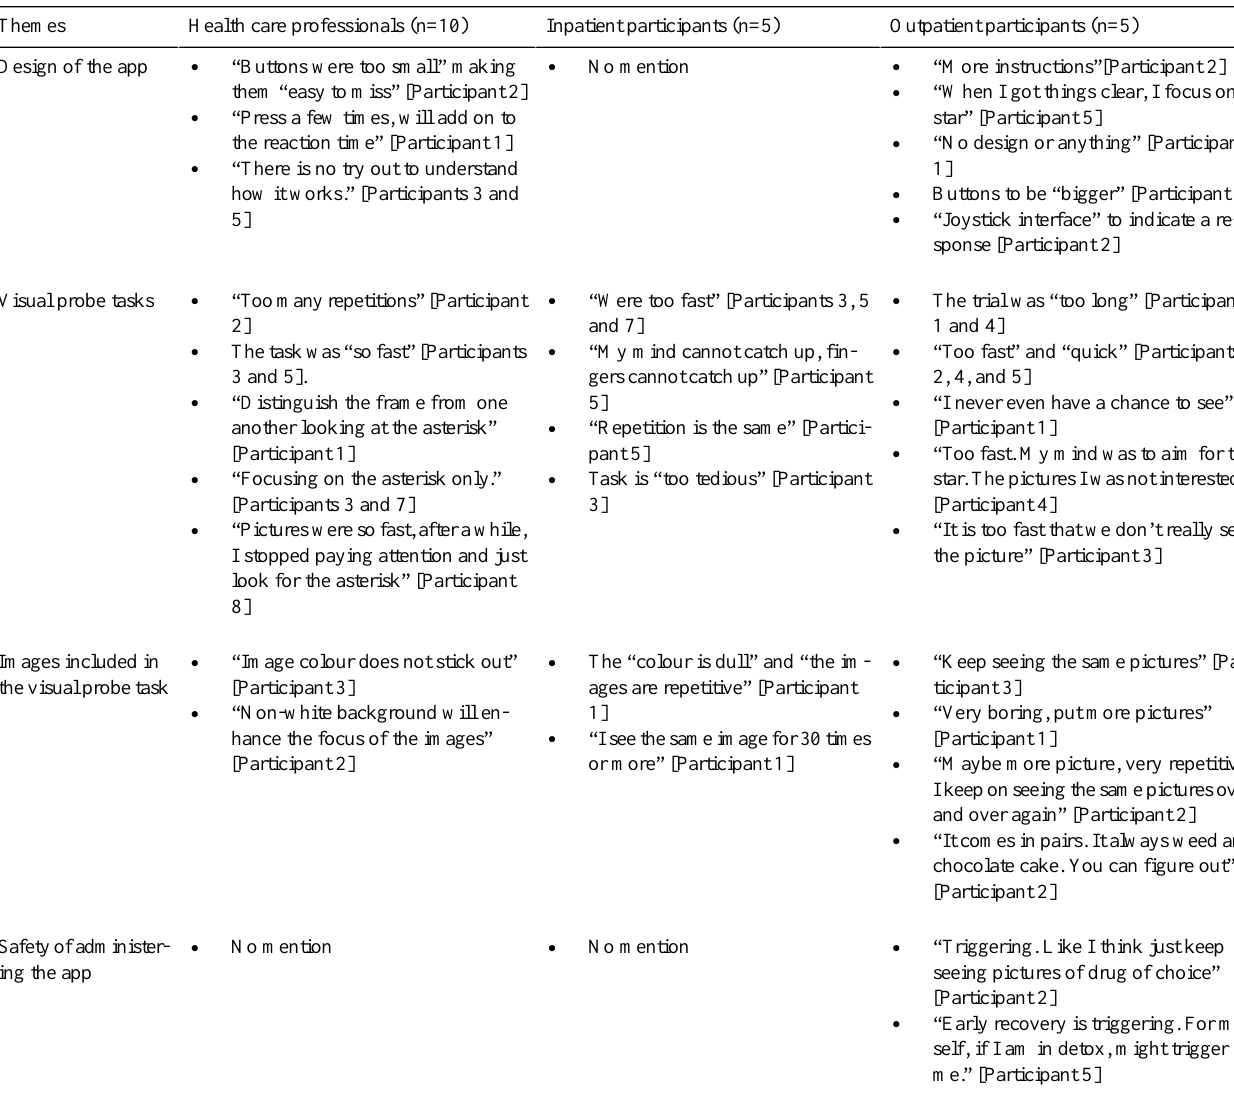
Table 2. Themes related to limitations of the existing